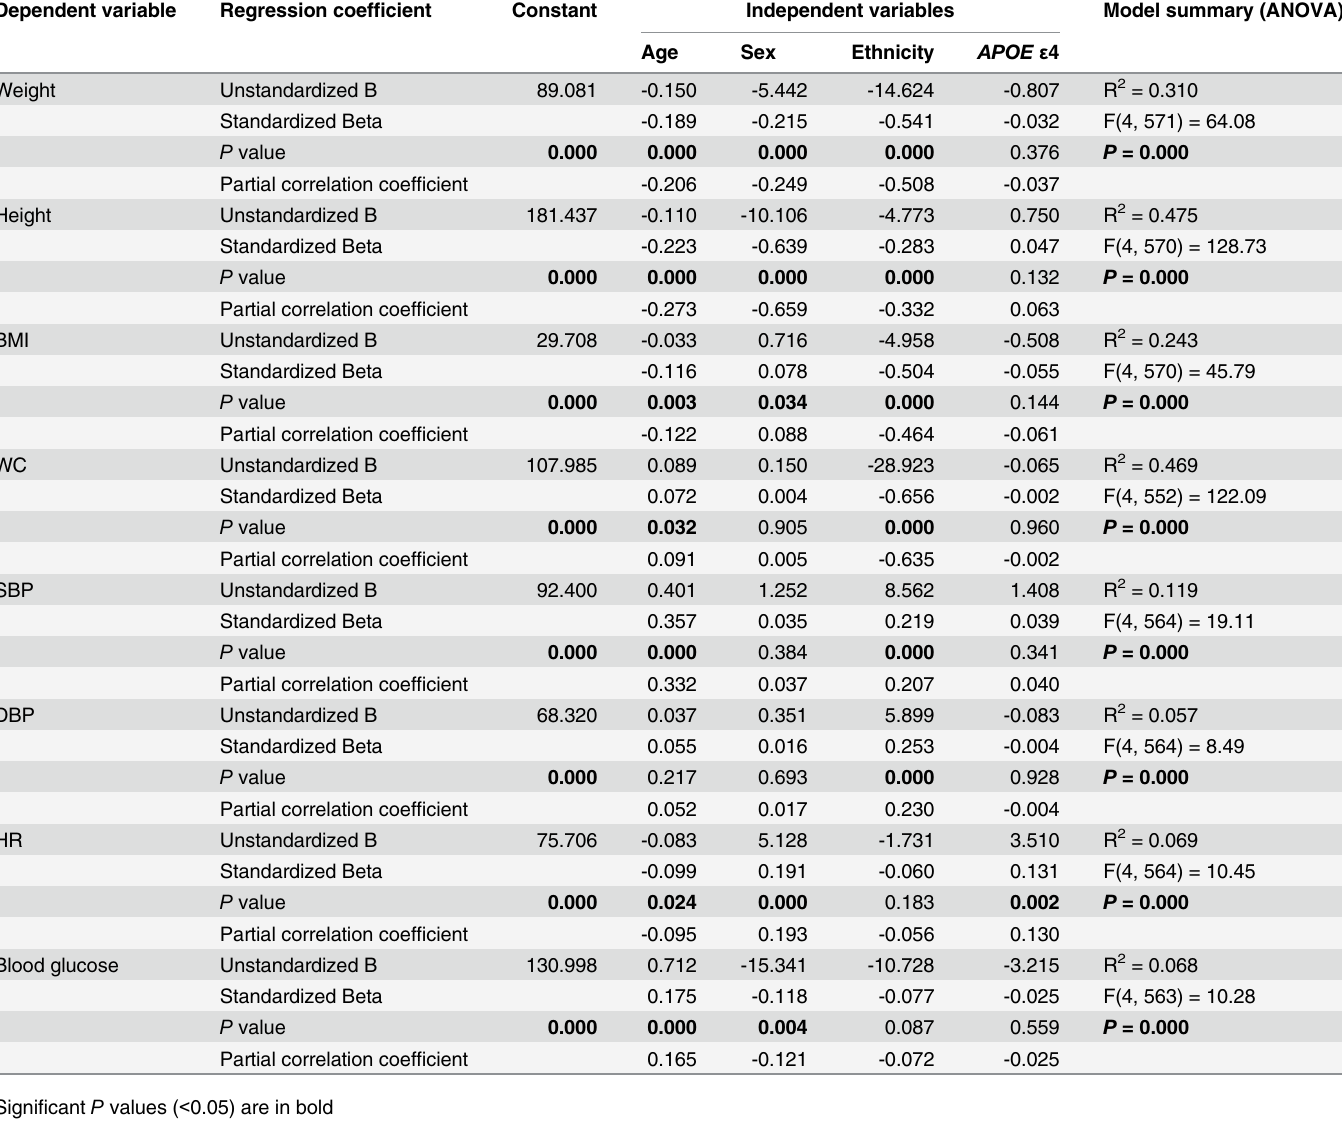
Table 5. Simultaneous multiple regression